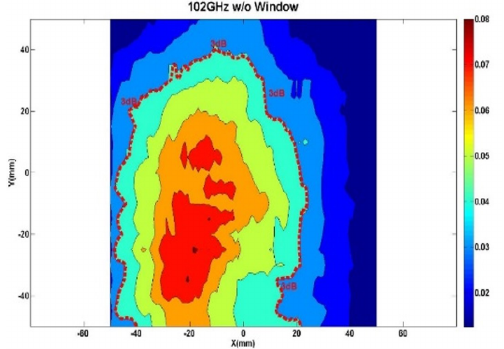
Figure 3. Beam radius inside the chamber without curvature window